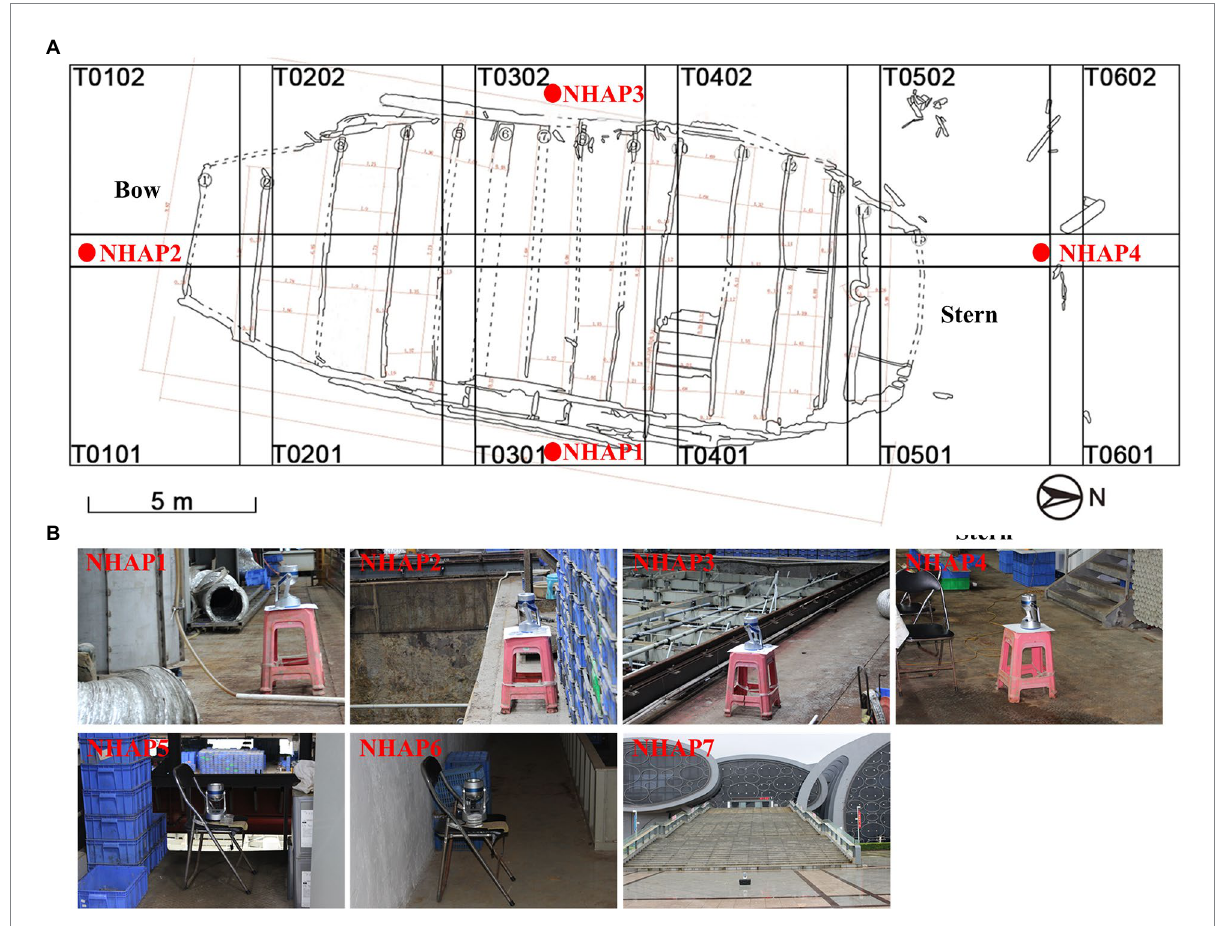
5 U/ μ L TransTaq-T DNA polymerase (TransGen